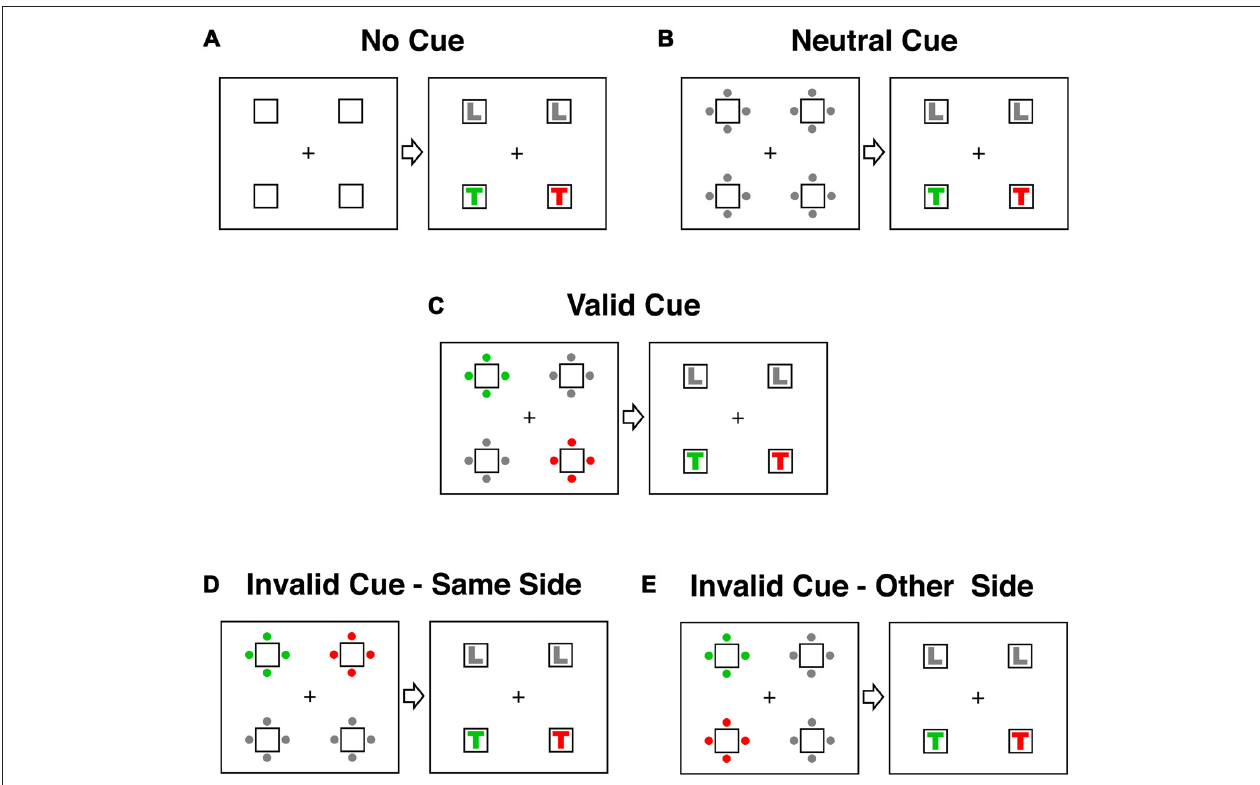
FIGURE 2 | Cue and target conditions in the contingent capture experiment. Responses were classified according to the spatial relationship between cue and target events. In the examples displayed here the target color is RED and the distractor color is GREEN. (A) The no-cue condition did not have a cue display. Instead the target appeared 1150–1550 after trial onset. (B) In the neutral condition all dots in the cue display were gray. (C) In the valid condition the target-colored (red) dots in the cue display appeared in the same location as the following target letter (red T). (D) In the “invalid-same-side” condition the target-colored cue appeared on the same side (left or right) as the target letter but at a different location (above or below). (E) In the “invalid-other-side” condition the target-colored cue appeared on the opposite side of the display to the target letter.